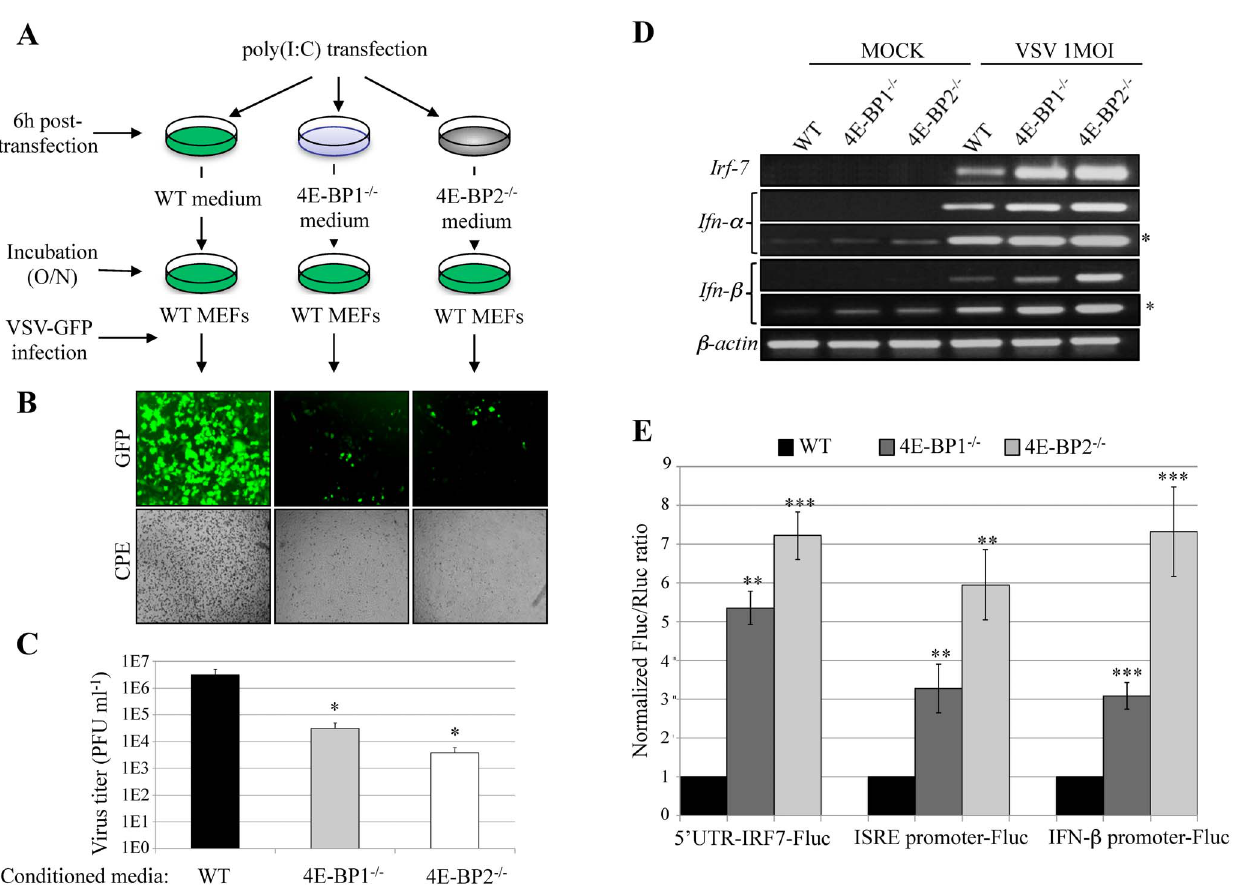
Fig. 3. Deficiency of 4E-BP1 or 4E-BP2 enhances type-I interferon production. (A) Protection assay: diagram of experimental protocol: after stimulation with poly(I:C) (6 hours) the medium of WT, 4E-BP1 2 / 2 and 4E-BP2 2 / 2 MEFs were collected and transferred to three different plates containing WT MEFs. (B) WT MEFs from (A) were then infected with VSV-GFP. The protective effects of the different media were assessed 24 hpi by fluorescence microscopy, cytopathic effect and (C) virus titration. (D) WT, 4E-BP1 2 / 2 and 4E-BP2 2 / 2 MEFs were infected with VSV at a MOI of 1 PFU/cell for 6 hours and the induction of a type-I IFN response ( Irf-7 , Ifn- a and Ifn - b mRNA levels) was determined by RT-PCR (*longer exposure). (E) Luciferase assays showing the ratio of expression of the different luciferase constructs harbouring either 5 9 UTR-IRF-7 (translational level), IFN- a promoter or IFN- b promoter (transcriptional level), normalized to the transfection control ( Renilla luciferase). Fluc activity/Rluc activity in WT MEFs was set as